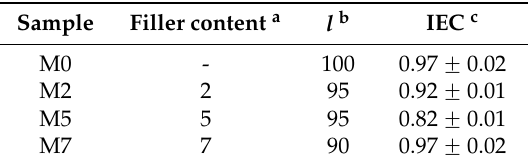
Table 2. Properties of the membranes M x ( x stands for % w/w of the filler).